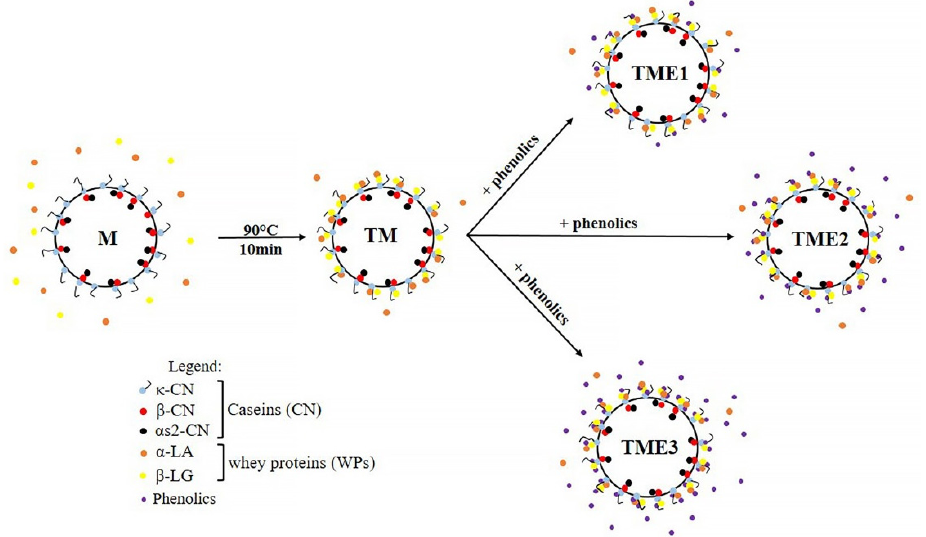
Figure 3. A schematic representation of the interactions between grape pomace seed phenolics at different concentration and casein micelles in thermally treated goat’s milk (90 ◦ C, 10 min), at natural pH = 6.7. Abbreviations: skimmed goat’s milk (M); thermally treated goat’s milk (TM); skimmed thermally treated goat’s milk/seed extract powder (0.2 mgTPC/mL) (TME1); skimmed thermally treated goat’s milk/seed extract powder (0.4 mgTPC/mL) (TME2); skimmed thermally treated goat’s milk/seed extract powder (0.6 mgTPC/mL) (TME3).